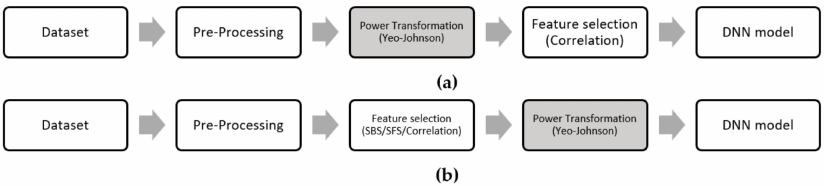
Figure 3. ( a ) Proposed flow for feature selection, and ( b ) traditional flow for feature selection.